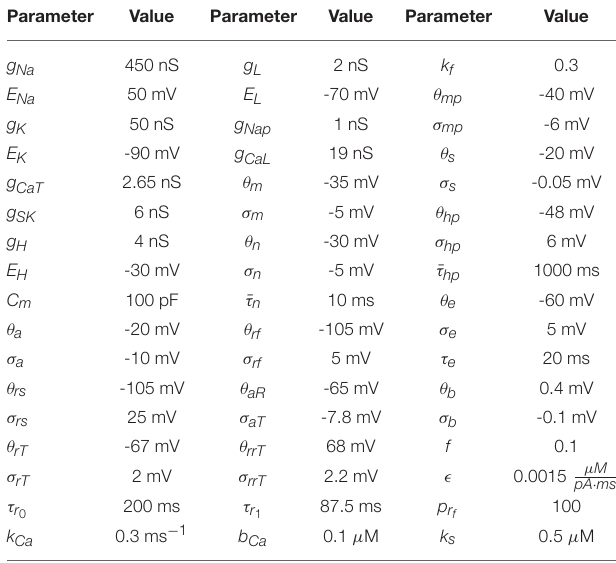
TABLE 1 | Parameter values used to numerically generate the HVC X data. The source of these values comes from Daou et al. [23]. Data was generated using an adaptive Runge-Kutta method, and can be seen in Figures 3A,B .